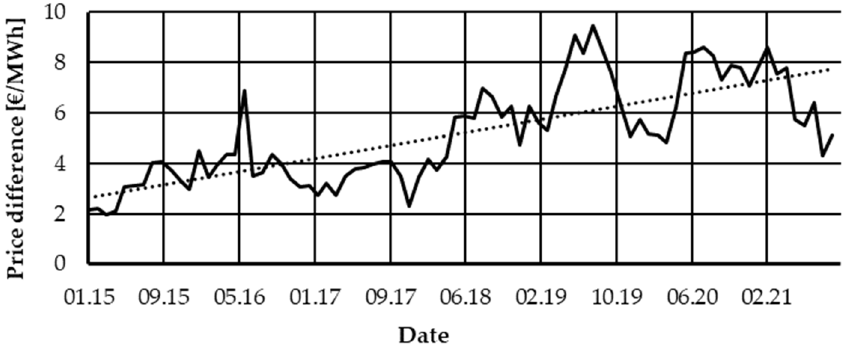
Figure 1. The price difference between electricity and natural gas [12]. Another aspect suggesting using distributed energy production is its stability. Re- gions with problems of a power outage can still be found in Poland. However, it should be kept in mind that a significant part of these situations is caused by planned breaks, in most cases resulting from maintenance works on the power grid. The average value of outages over 2015–2020 was 413 MWh for 77 min. From these values, the value of un- planned outages was 94 MWh for 17 min [13]. For example, in Germany, which has one of the most reliable power grids in Europe, in 2015 there were 12 min and 42 s of power outages which was a consequence of extreme weather events. In Brazil, power cuts are more than 24 h a year, while in Japan it is 6 min a year. This result is caused by used energy